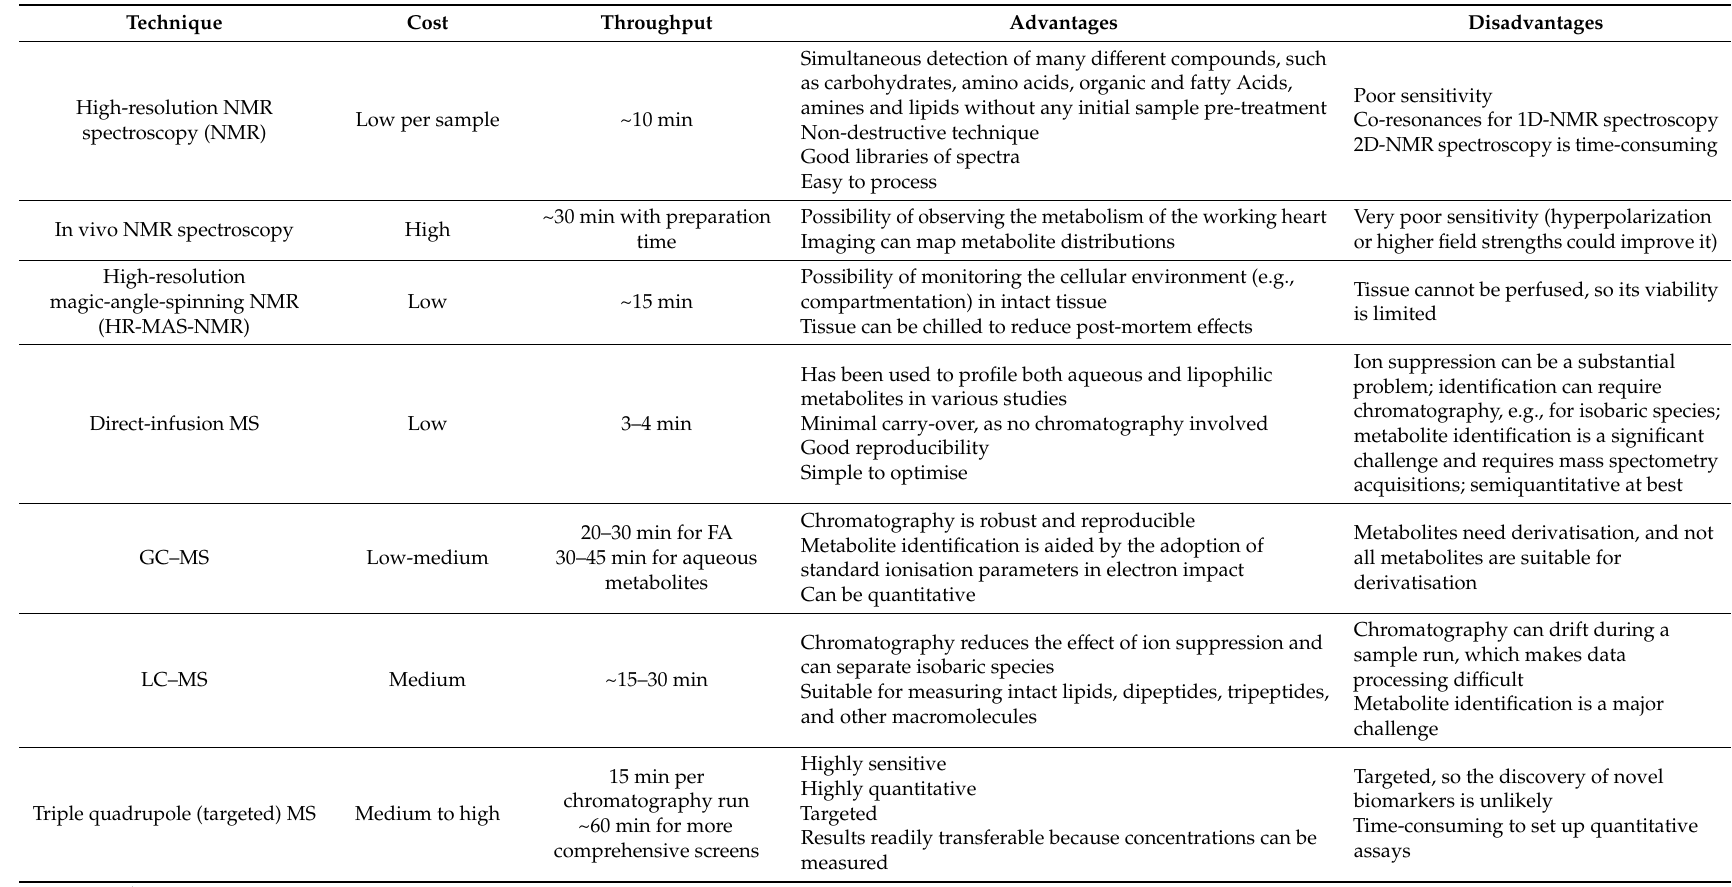
Table 1. Analytic techniques used in metabolomic studies (adapted from Deidda et al.